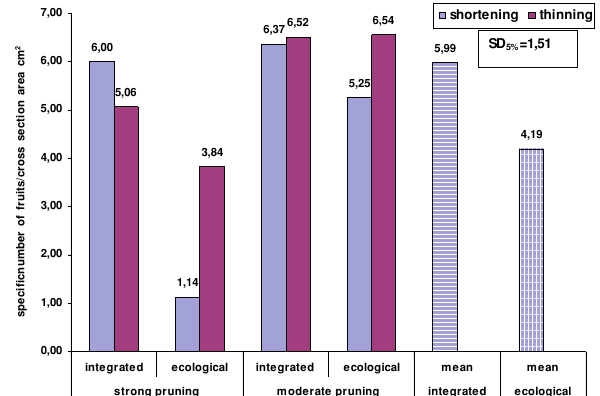
Figure 3. The effect of the intensity of pruning on the specific fruit load of ‘Idared’ apple trees grafted on M 26 rootstock in ecological as well as in integrated growing systems (Debrecen-Pallag,